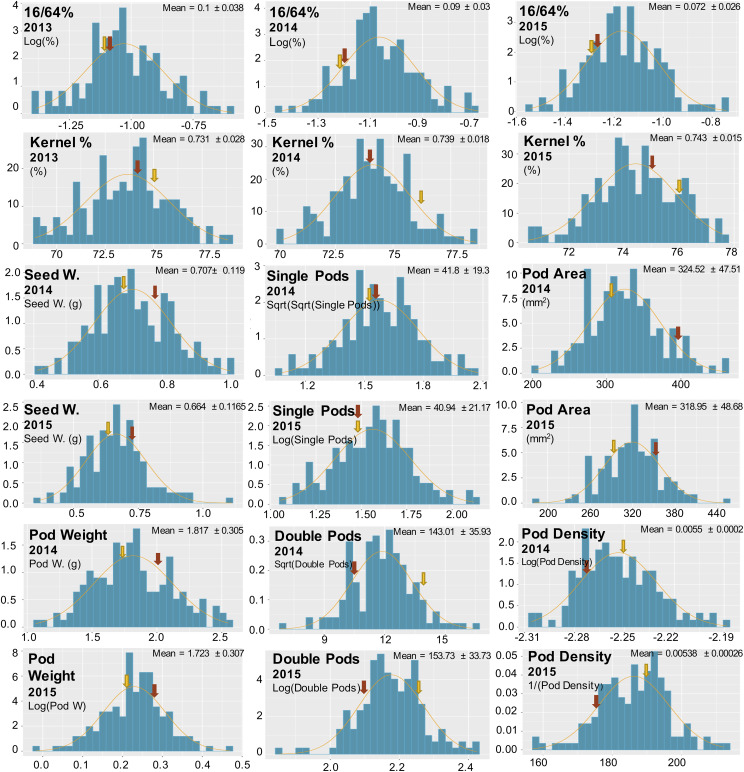
Phenotypic distribution for all traits in three consecutive years. Y-axis corresponds to density, and X-axis corresponds to the original metric or the normal-transformed trait value as indicated in the left corner or each plot, based on the average of the three replicates per year. Log, logarithm; Sqrt, square root; 1/, reciprocal. Arrows indicate the phenotypic values for NC 3033 (red) and Tifrunner (yellow). A normal distribution curve is shown in orange. The mean and SD values are based on the raw data according to Table 1.